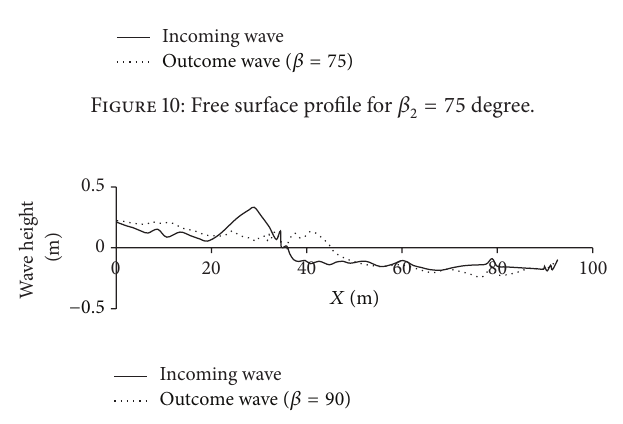
Figure 11: Free surface profile for 𝛽 2 = 90 degree.